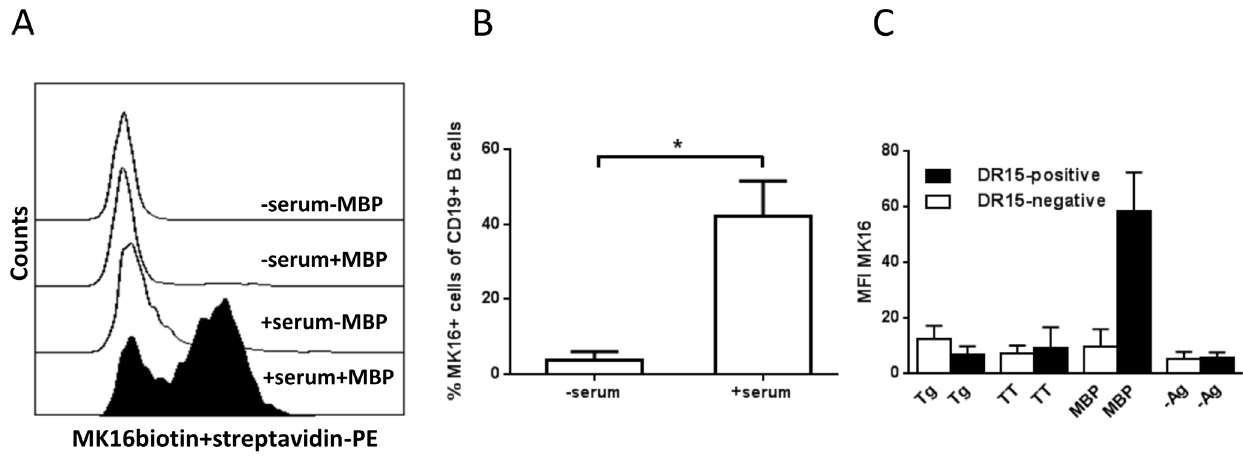
Figure 3. Presentation of MBP85-99 by HLA-DR15 + B cells. PBMCs from HLA-DR15 + individuals were incubated with MBP (whole protein) in the presence or absence of normal serum (30% v/v) for 18 h. Biotinylated mAb MK16 and streptavidin-PE were used as markers of MBP85-99 presentation. A) Representative histogram plot of 5 healthy donors showing binding of MK16 to live (7AAD-negative) B cells in the absence or presence of serum and MPB. B) The percentages of MK16-positive live B cells in 5 healthy HLA-DR15 + donors are shown; background values (no MBP added) have been subtracted. C) MK16 staining of B cells incubated with 30 m g/ml thyroglobulin (Tg), tetanus toxoid (TT), myelin basic protein (MBP) or no antigen (-Ag) in 4 healthy HLA-DR15 + donors (black bars) and 4 healthy HLA-DR15/16 negative donors (white bars). Means and SEM are shown.